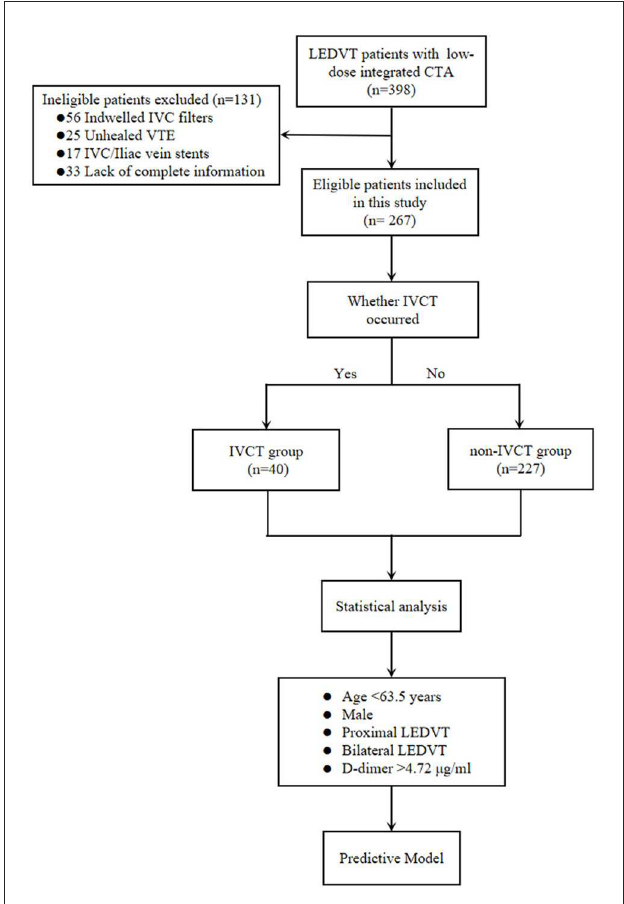
FIGURE1 The study flowchart of the inclusion and exclusion criteria of LEDVT patients and the predictive model-building process. LEDVT, lower extremity deep vein thrombosis; CTA, computed tomography angiography; IVC, inferior vena cava; VTE, venous thromboembolism; IVCT, inferior vena cava thrombosis; DVT, deep vein